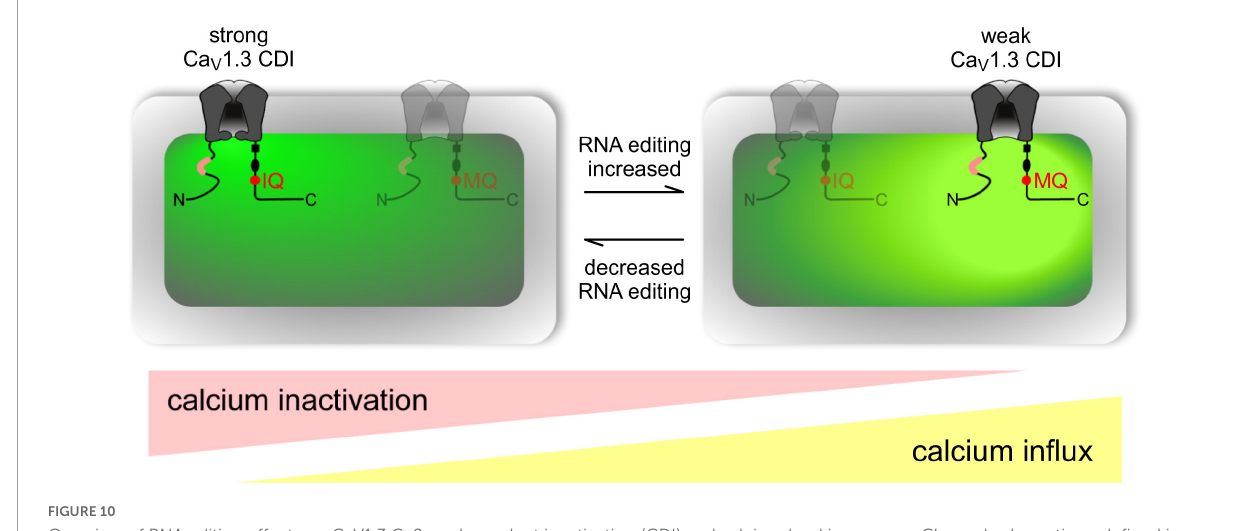
FIGURE10 Overview of RNA editing effects on CaV1.3 Ca2 + -dependent inactivation (CDI) and calcium load in neurons. Channel schematic as defined in Figure above. Increased RNA editing (right scenario) favors channels with MQ and other edited versions of the IQ domain, decreasing overall CDI and presumably increasing cellular Ca2 + load (intense yellow-green coloration). Decreased editing (left scenario) favors default channels with IQ version of IQ domain, increasing overall CDI and potentially decreasing cellular Ca2 + load (weak yellow-green coloration). Actual neurons reside on a continuum between these two extremes, as represented by ramp schematics at bottom. Figure from Huang et al. (2012), obtained by Elsevier under license No